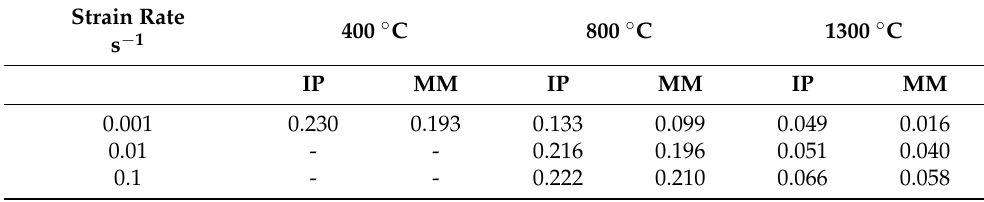
Figure 7. Example of d σ /d ε vs. σ curve used in the approach of Poliak and Jonas to determine the critical stress for DRX initiation σ c . Table 1. ε c values of IP and MM samples at different temperatures and strain rates.